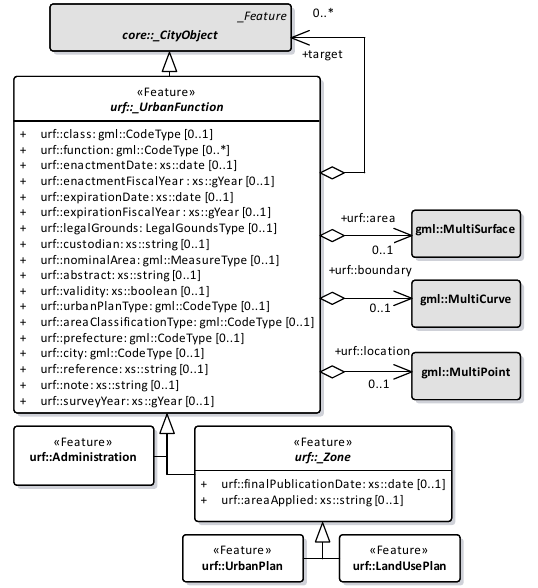
Figure 6. A part of the UML class diagram of the Urban Function Module